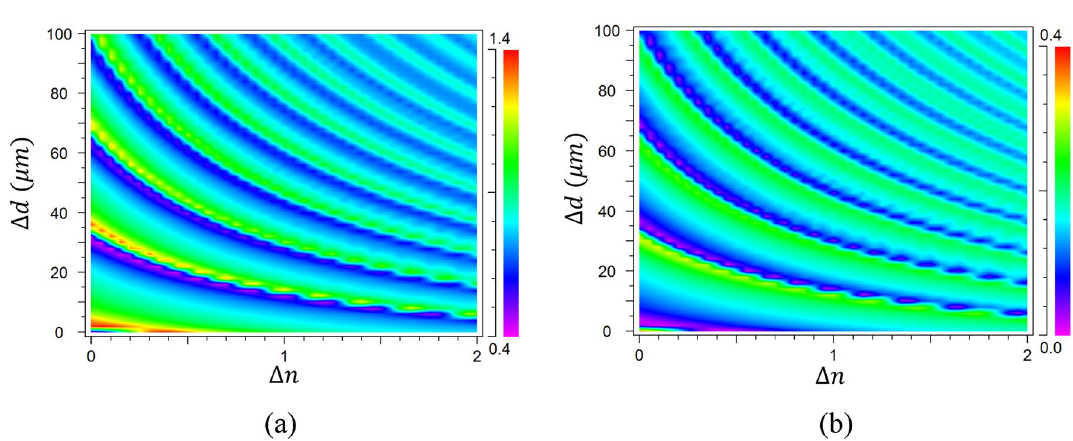
Figure 2. Intensity of surface waves at 3.75 THz before ( a ) and after ( b ) the single grey groove of varying depth (Δ d ) and refractive index (Δ n